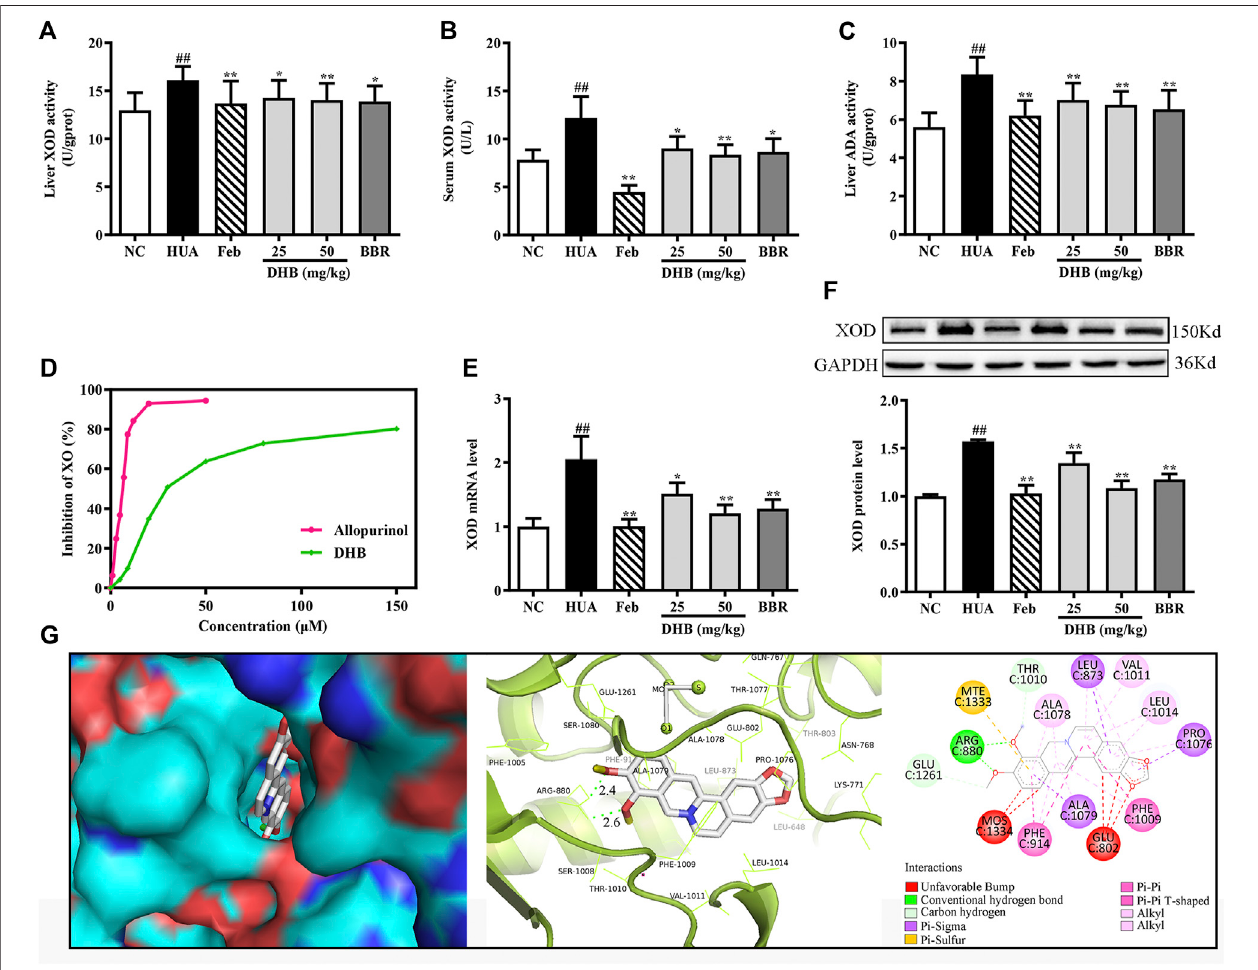
FIGURE 4 | Effect of DHB on XOD in vitro and in vivo . (A) Liver XOD activity, (B) serum XOD activity, (C) liver ADA activity, (D) in vitro XOD inhibition by DHB, (E) relative mRNA levels of hepatic XOD by RT-qPCR after normalized to β -actin, (F) relative protein levels of hepatic XOD by Western blot assay, and GAPDH was used as the control. Bar chart showed quantitative evaluation of XOD bands by optical density. (G) Molecular docking modeling of DHB with XOD. The results are expressed as mean ± SD (n (cid:2) 10). # p < 0.05, ## p < 0.01, compared with NC group; *p < 0.05, **p < 0.01, compared with HUA group.